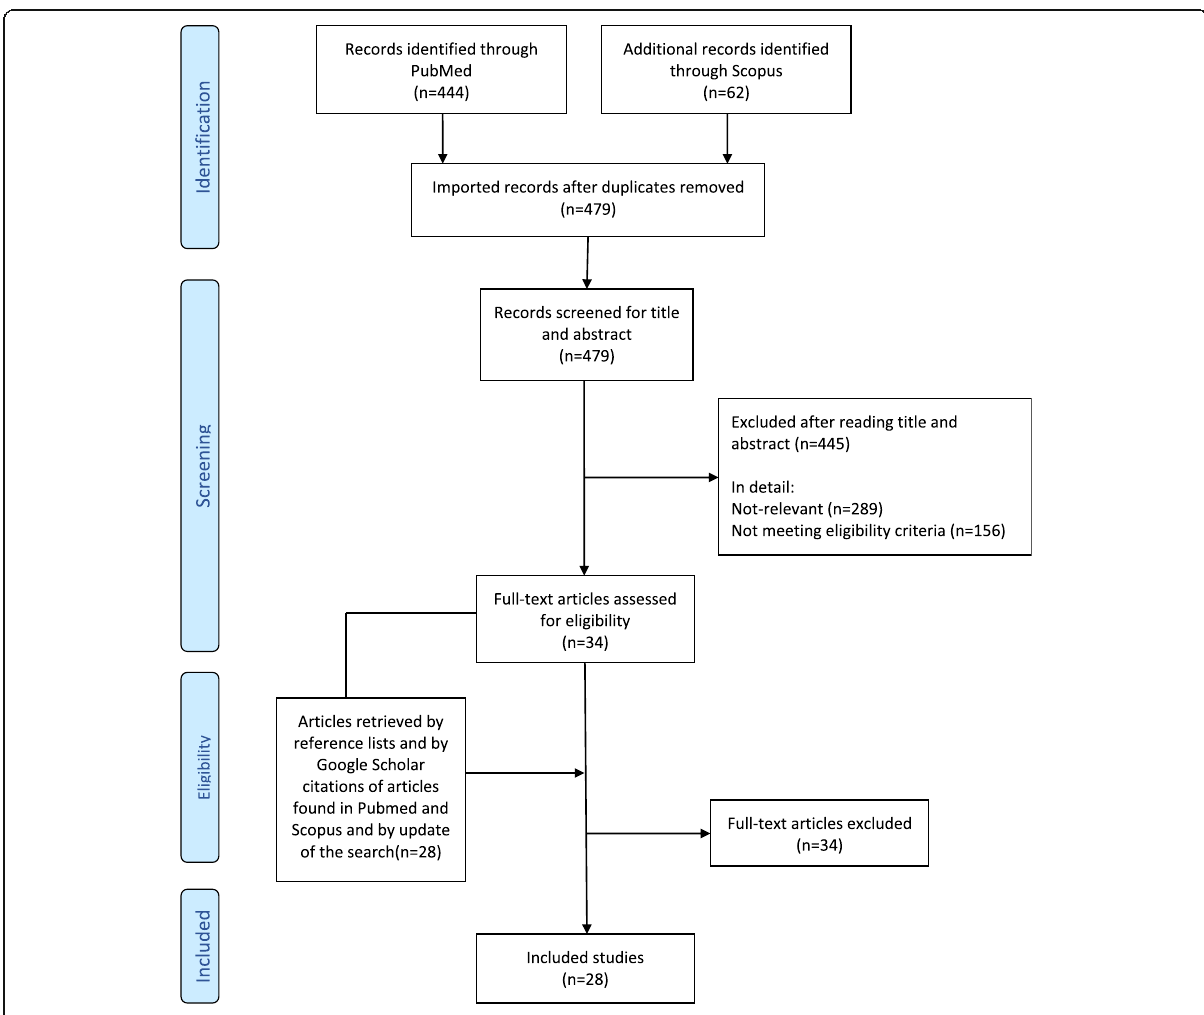
Fig. 1 Process of identifying eligible studies for the